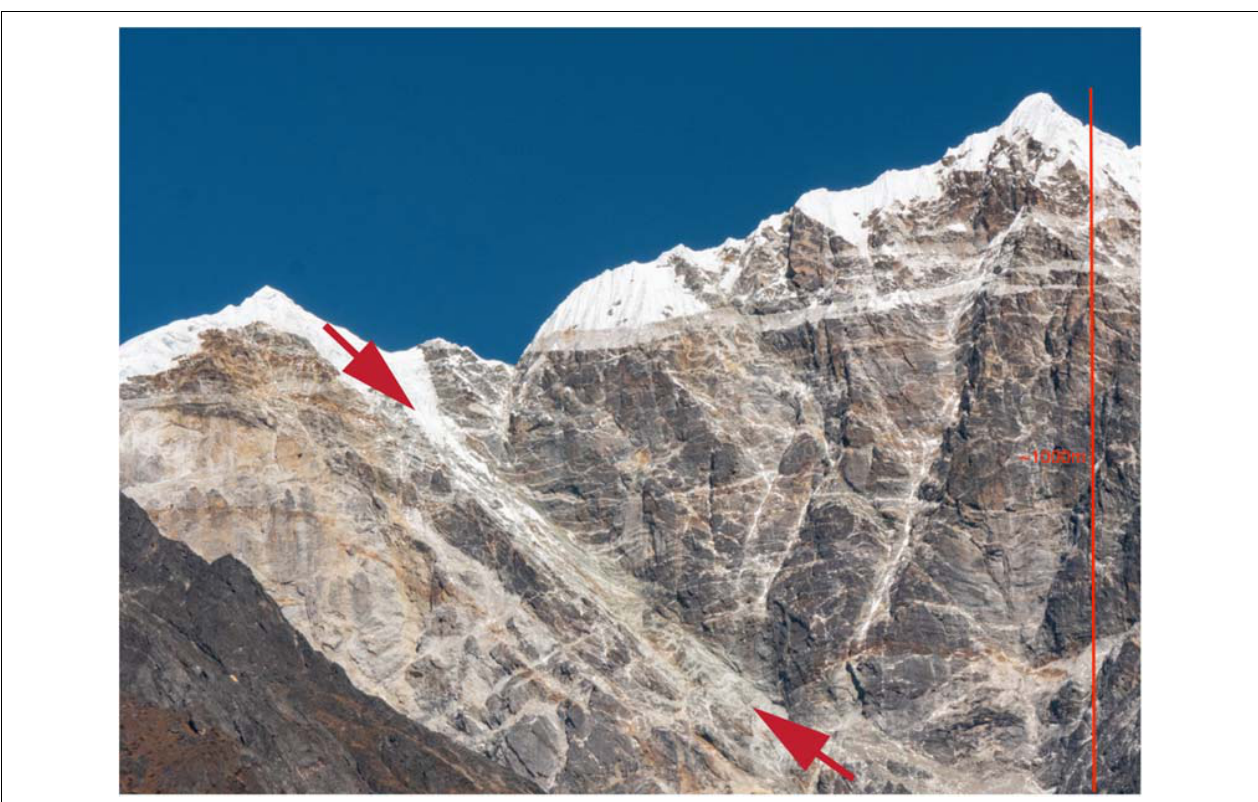
FIGURE 3 | Photograph showing strand of Benkar Fault zone. The view is looking north at the west ridge of Taboche (see location in Figure 4 ), a peak in the mapped portion of the Benkar Fault zone, in the Khumbu region of Nepal. Red arrows show a zone of shearing to the right (east) of the leucogranite exposure. The vertical profile in this photo is ∼ 1,100 m. This zone has apparent normal displacement within the NE-striking, Benkar Fault zone that has overall dextral, normal sense of shear (photo by Mary